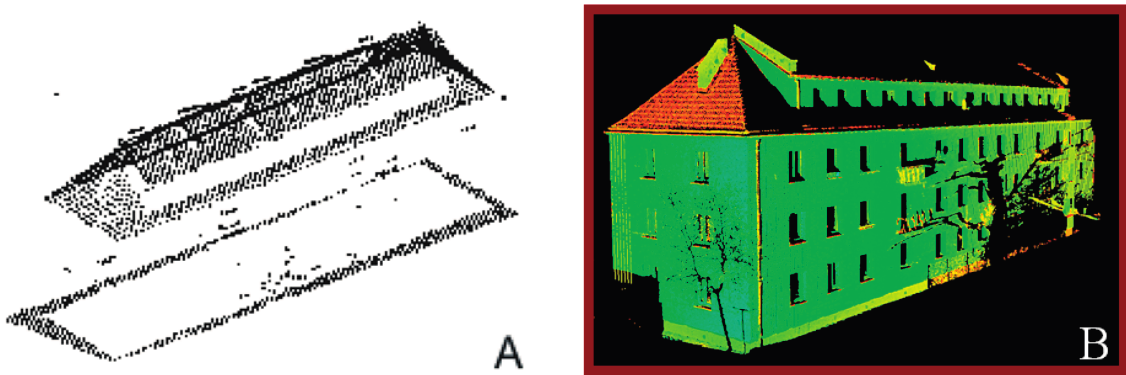
Figure 1. Block of flats, perspective view. ( A ) Aerial Laser Scanning data; ( B ) Terrestrial Laser Scanning data (intensity